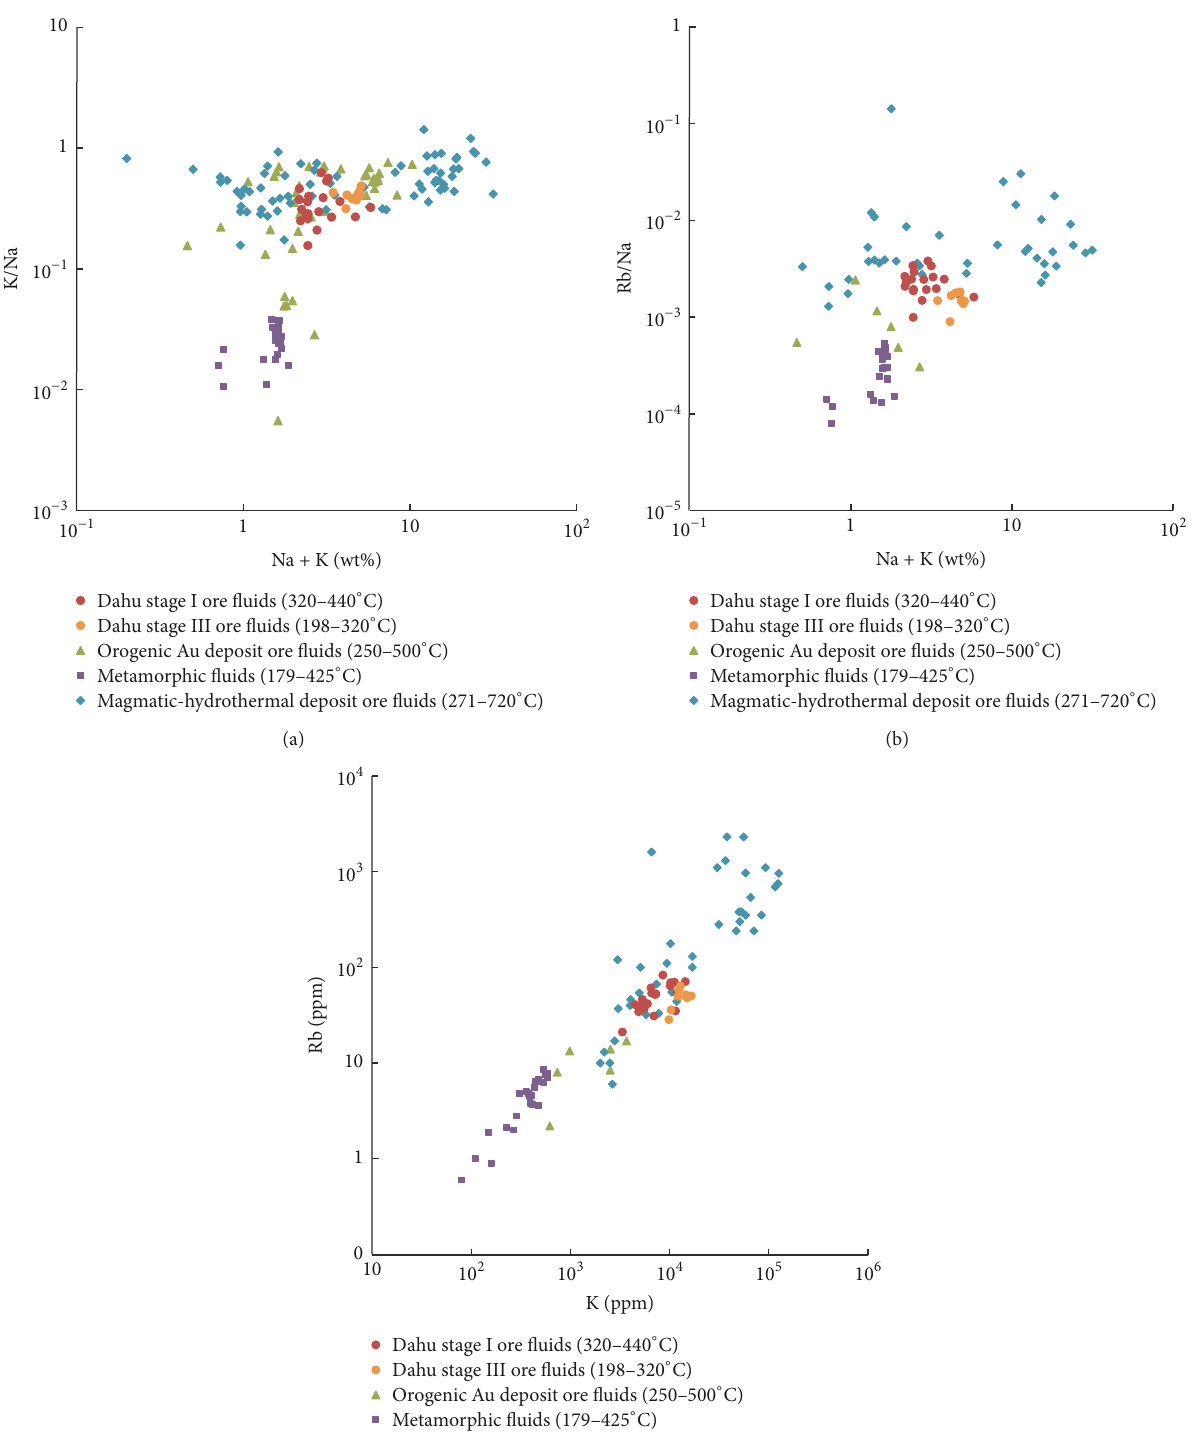
Figure 5: Fluid compositions of the Dahu deposit compared to other hydrothermal systems. (a) Fluid compositions plotted in K/Na (weight ratio) versus Na + K space. (b) Fluid compositions plotted in Rb/Na (weight ratio) versus Na + K space. (c) Fluid compositions plotted in Rb versus K space. Estimated trapping temperatures for fluid inclusions are shown in brackets. Data for orogenic Au deposit ore fluids are from Yardley et al. [34], Hodge [29], Garofalo et al. [30], and Morales et al. [31], for metamorphic fluids from Marsala et al. [35] and Miron et al. [36], and for magmatic-hydrothermal deposits (i.e., porphyry and intrusion-related deposits) from Ulrich et al. [9], Rusk et al. [37], Klemm et al. [10, 11], Aud´etat et al. [38], Seo et al. [12], Stefanova et al. [17], and Catchpole et al.